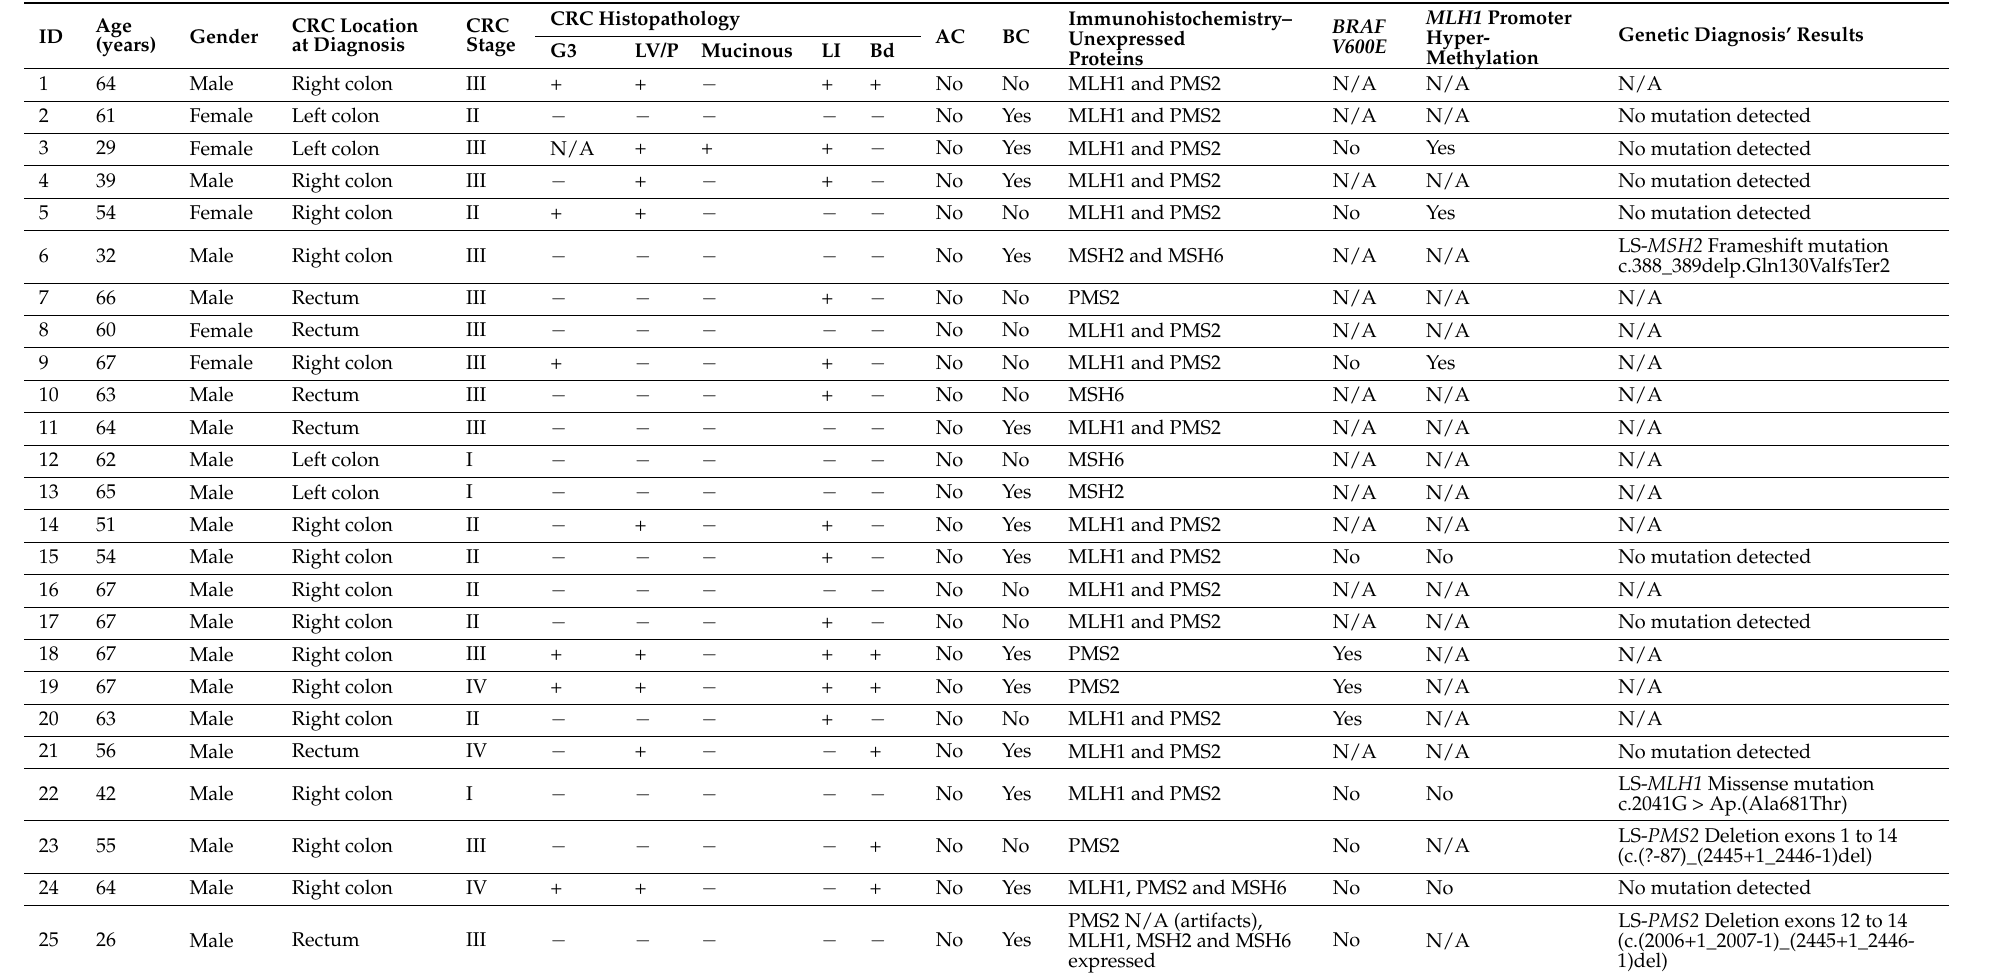
Table 4. Clinical and molecular characterization of cases with altered MMR status by immunohistochemical